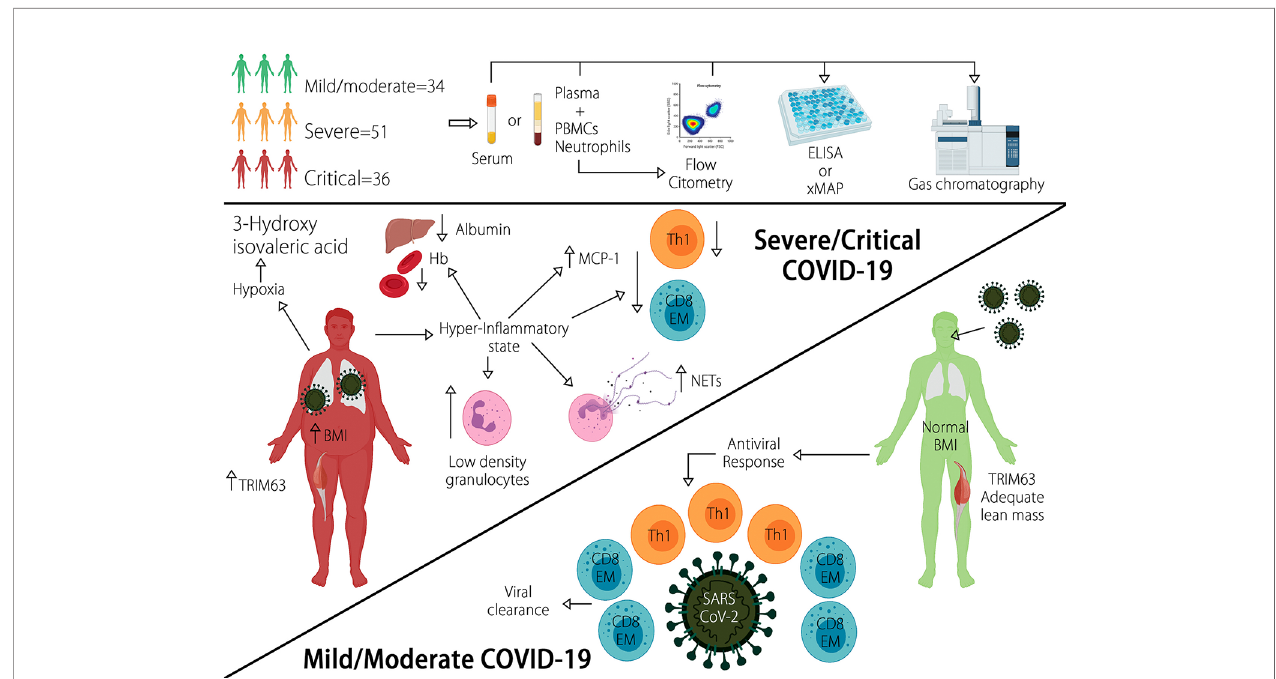
FIGURE 3 | Diverse clinical and biological traits are able to accurately predict COVID-19 severity. Severe/critical disease is characterized by increased BMI, LDGs, circulating NETs, plasma TRIM63, and serum 3-Hydroxyisovaleric acid, as well as diminished levels of Hb, albumin, and lymphopenia of Th1 and CD8 + effector memory T